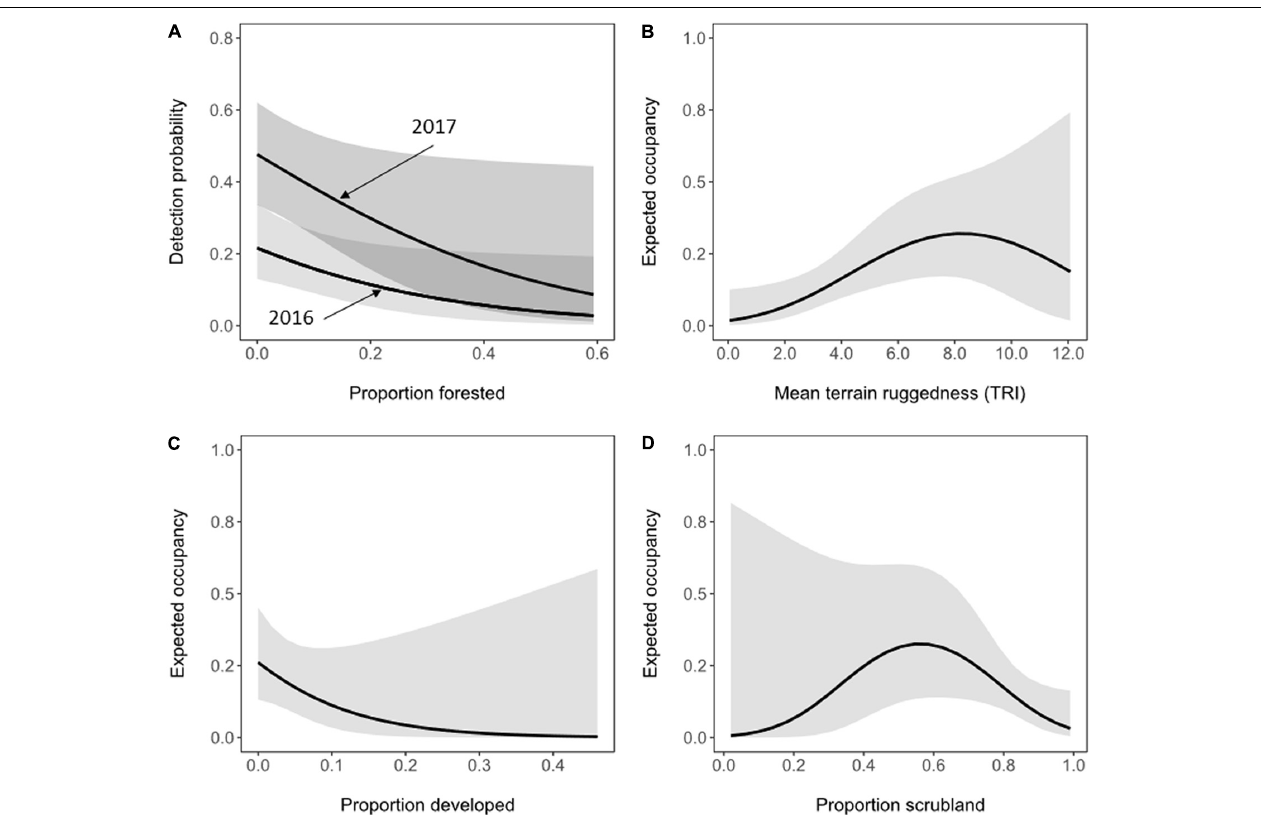
FIGURE 2 | Influence of landscape composition on the probability of detection (A) and expected site occupancy (B–D) of territorial pairs of golden eagles in coastal southern California, United States, 2016 – 2017. Solid lines represent estimates from the best model containing each landscape covariate while holding all other covariates in the model at median values. Shading represents 95% confidence intervals.